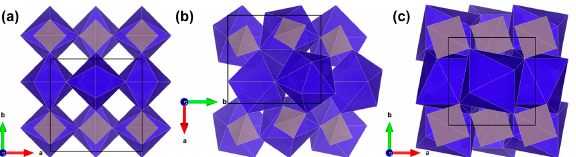
Figure 1. [001] views of REPO 4 structure in the ( a ) xenotime, ( b ) monazite, and ( c ) scheelite phases. RE-O polyhedra are shown in violet, PO 4 tetrahedra are shown in grey, and the unit cell boundaries are shown as thin black boxes. The 90 ◦ rotation of monazite axes with respect to those of xenotime and scheelite is a result of the monoclinic cell setting of monazite, as shown in detailed transformation schemes reported by Hay et al. [5]. Structures are visualized using the VESTA software